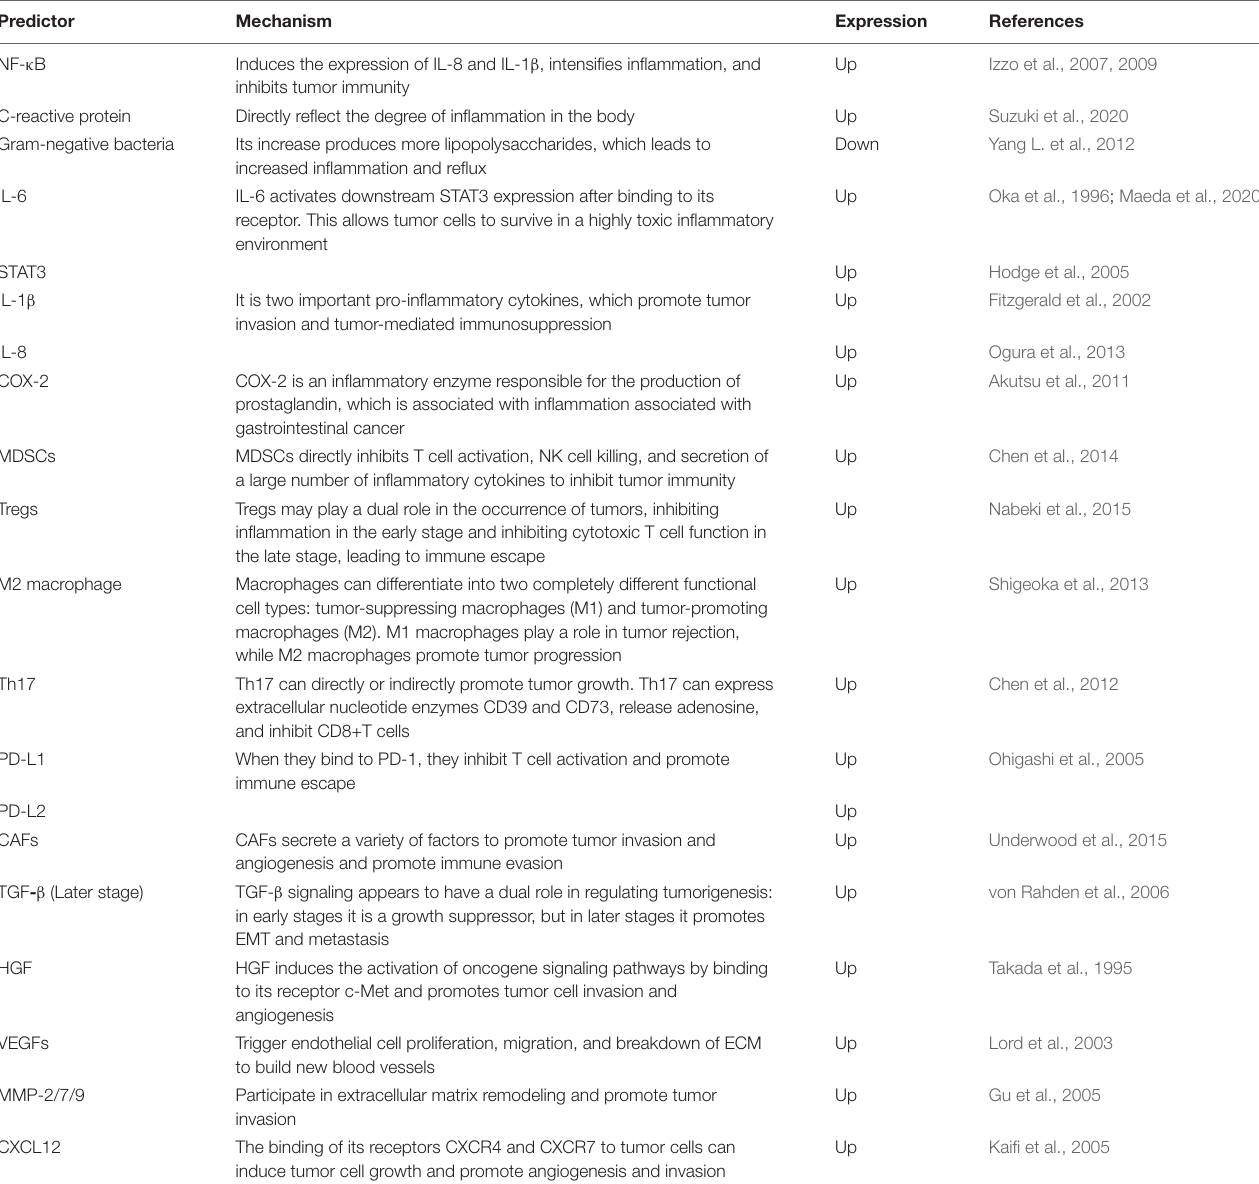
TABLE 2 | Factors and cells associated with poor esophageal cancer prognosis and their mechanisms of action. Predictor Mechanism